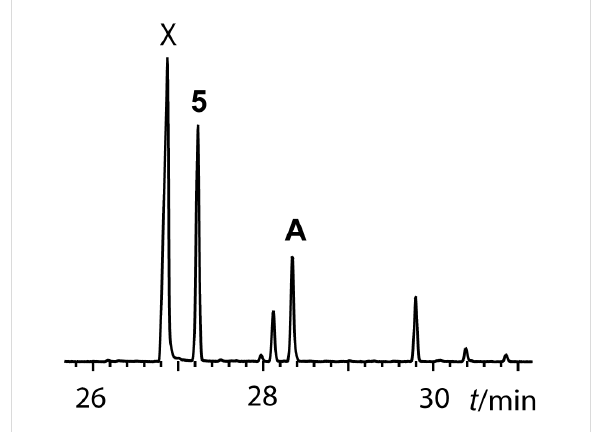
Figure 2: Total ion chromatogram of the gular gland extract of Hyper- olius cinnamomeoventris . X: frog anaesthetic ethyl